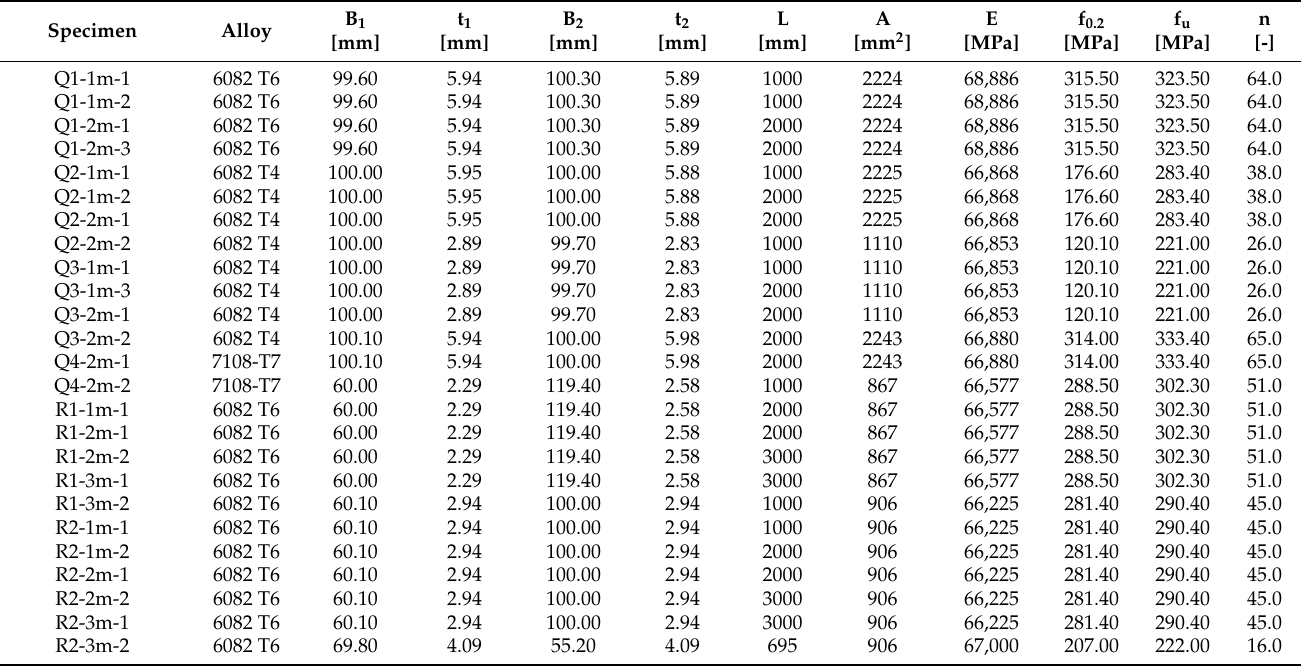
Table A2. Experimental properties of three-point bending